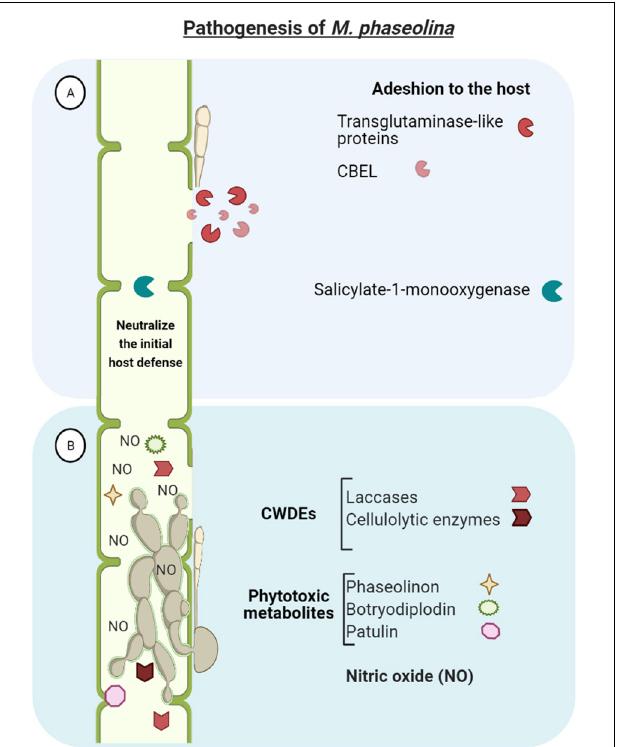
FIGURE 3 | Macrophomina phaseolina genome encodes a large repertoire of pathogenicity-associated genes which enables to (A) adhere to the host tissue (e.g., CBEL-cellulose binding elicitor lectin and transglutaminase-like proteins), neutralize the initial host defense (i.e., salicylate-1-monooxygenase), and penetrate and invade plant tissues. (B) Once in the host, the pathogen releases an array of different toxins and cell wall degrading enzymes (CDWEs) and finally disrupt the vascular system and overthrow host defense, resulting in host cell death and disease